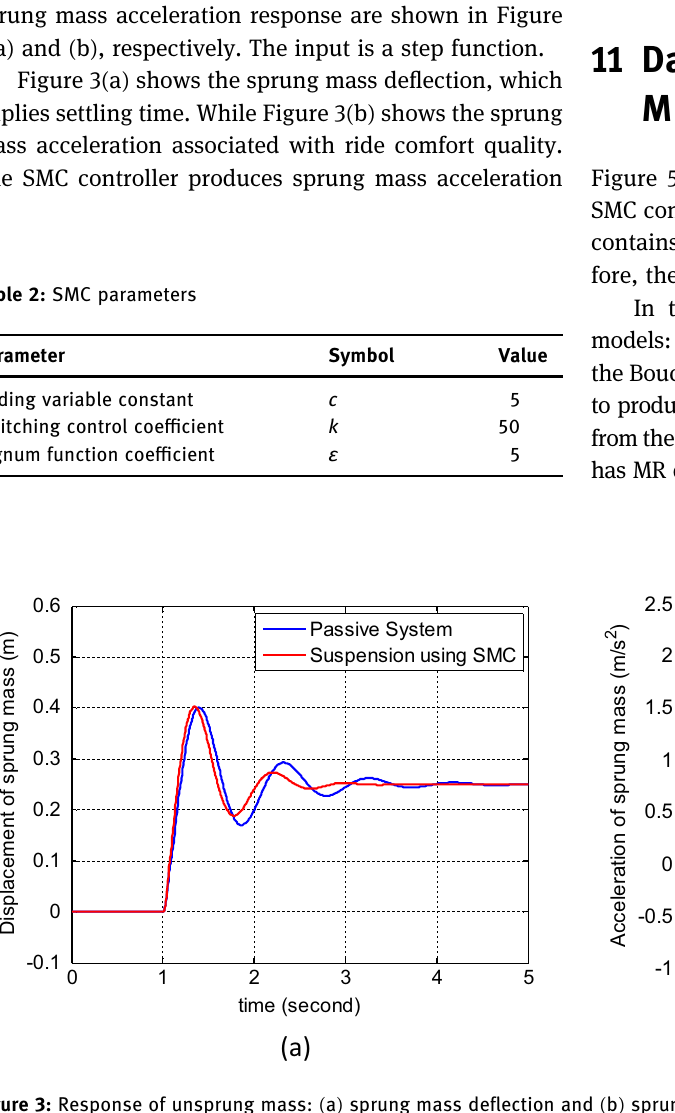
Figure 3: Response of unsprung mass: ( a ) sprung mass de fl ection and ( b ) sprung mass